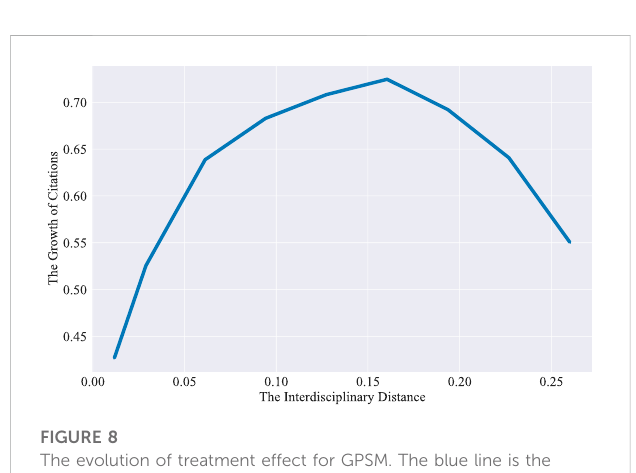
FIGURE 8 The evolution of treatment effect for GPSM. The blue line is the growth of citations G c , which is the same as Figure 7. The horizontal and vertical axis represents the interdisciplinary distance and the growth of citations,